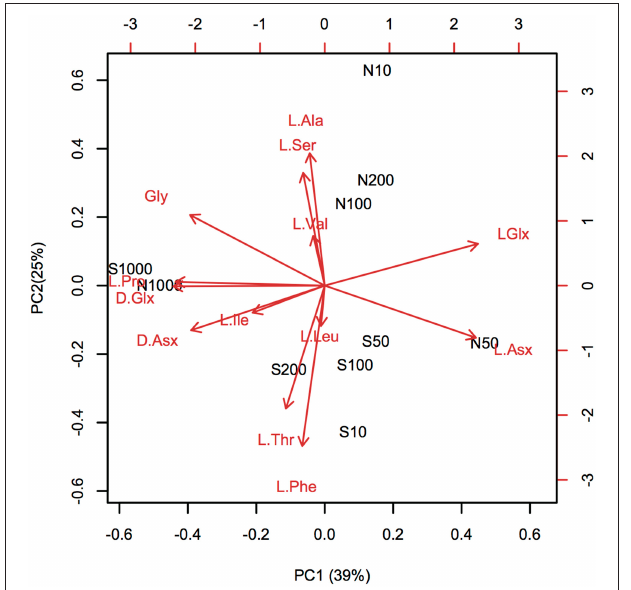
FIGURE 3 | Principal component analysis (PCA) of particulate amino acid (AA) compositions. The biplot of the first two PCA axes (PC1 and PC2) shows site scores and variable loadings (red arrows). AA abbreviations are the same as in Figure 2 . L-methionine and D-amino acids, except for D-Asx and D-Glx, were excluded from the PCA analysis, because these amino acids were under the quantification limits in the POM collected in the deep layers. Site scores are labeled as “station code-depth.” Statistical parameters are tabulated in Supplementary Table 1.